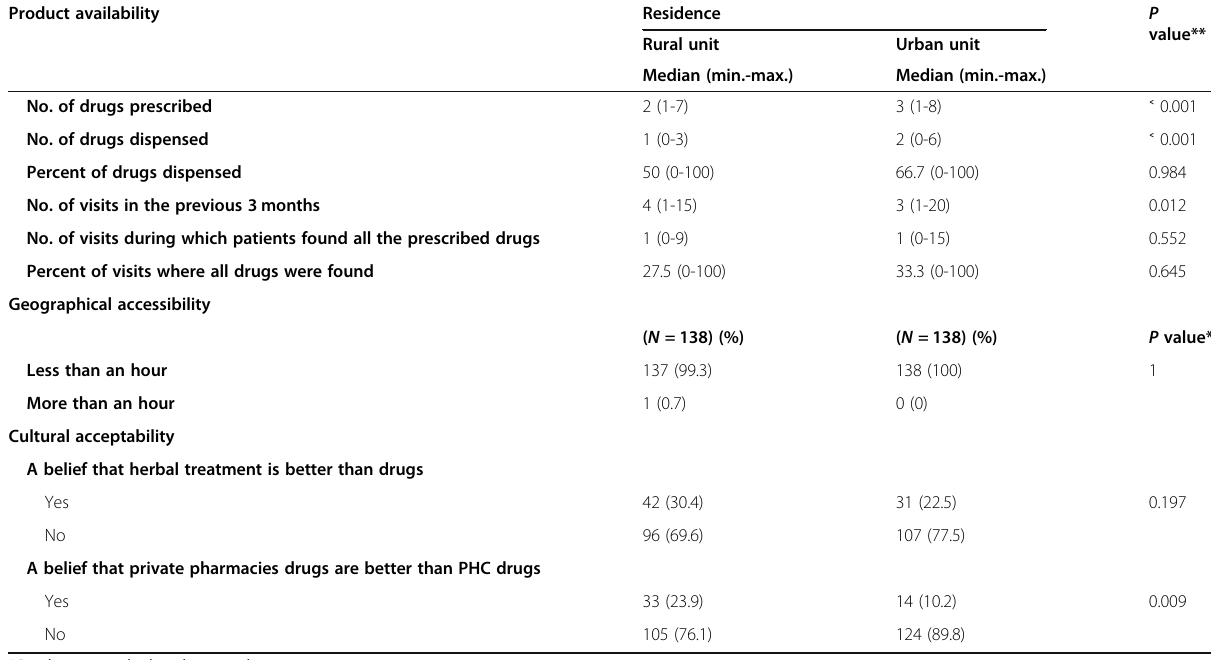
Table 3 Product availability, cultural acceptability, and geographical accessibility to PHC units providing essential drug list to rural and urban groups during the study period